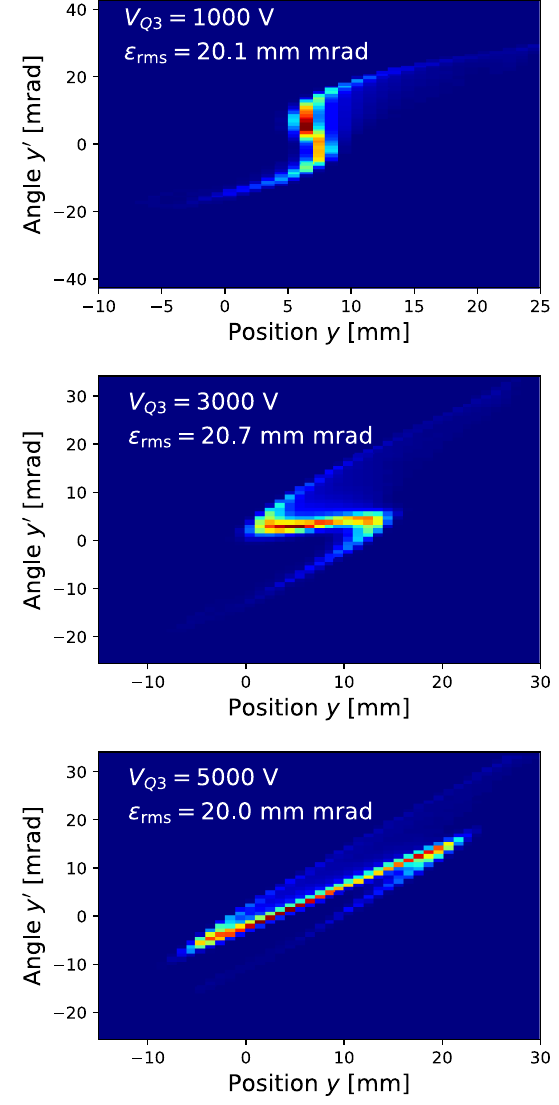
FIG. 12. y - y 0 phase-space projections measured at the FRIB front end during a quadrupole scan. V last quadrupole upstream of the Allison